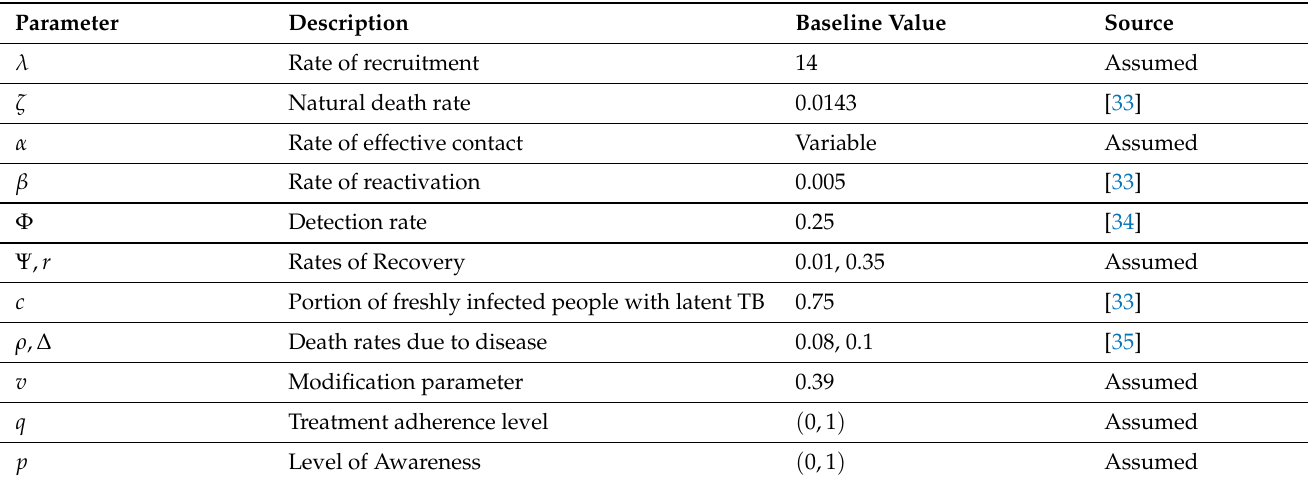
Table 2. Parametric values of the proposed model.